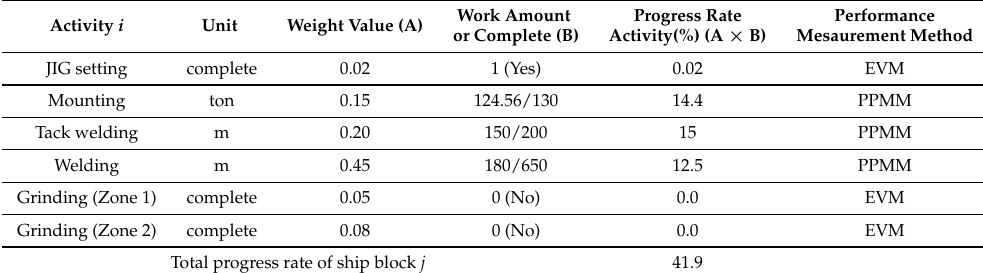
Table 1. Example of progress measurement of ship block j